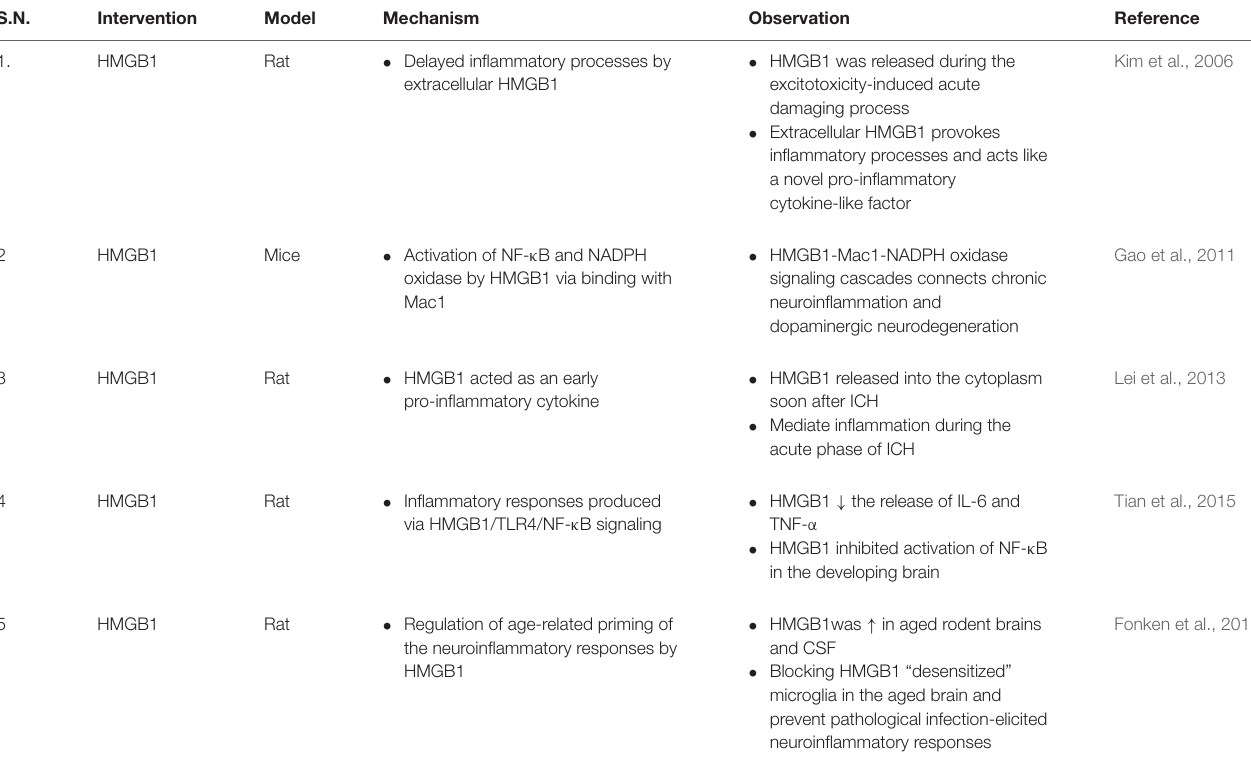
TABLE 2 | Summary of findings reporting HMGB1 in neuroinflammation mediated conditions.